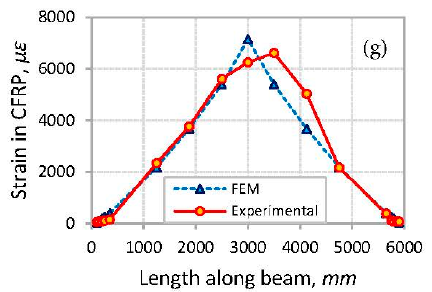
Figure 12. Comparison of strain distribution along the CFRP laminates from FE analysis and experimental results [47]: ( a ) beam S-1.5; ( b ) beam S-2.0; ( c ) beam S-2.5; ( d ) beam S-3.0; ( e ) beam S-3.5; ( f ) beam S-5.0; ( g ) beam S-7.0.